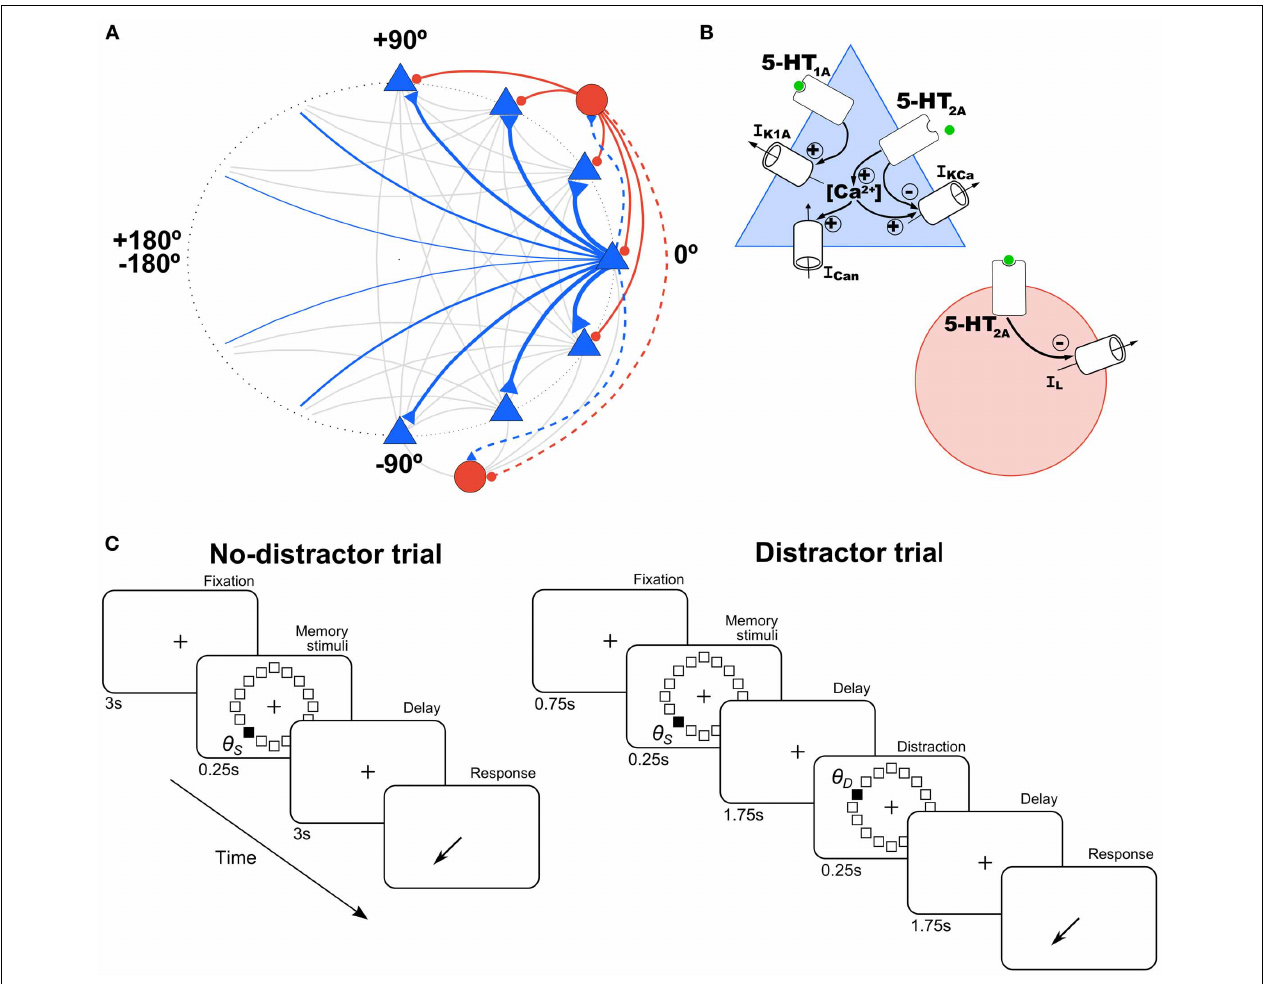
FIGURE 1 | Schematic of network architecture and 5-HT modulation in model neurons. (A) Scheme of the ring structure of the network model with excitatory pyramidal neurons (blue triangles) and inhibitory interneurons (red circles) in a proportion of 4:1 interconnected within and between them. Nearby pyramidal neurons are strongly connected with each other (strength indicated by thickness of connections). Connections onto pyramidal neurons are indicated with a solid line and onto interneurons with a dashed line. (B) In pyramidal cells (blue triangle), 5-HT has an inhibitory effect via 5-HT 1A receptors by increasing a K + current ( I K 1 A ), and an excitatory effect via